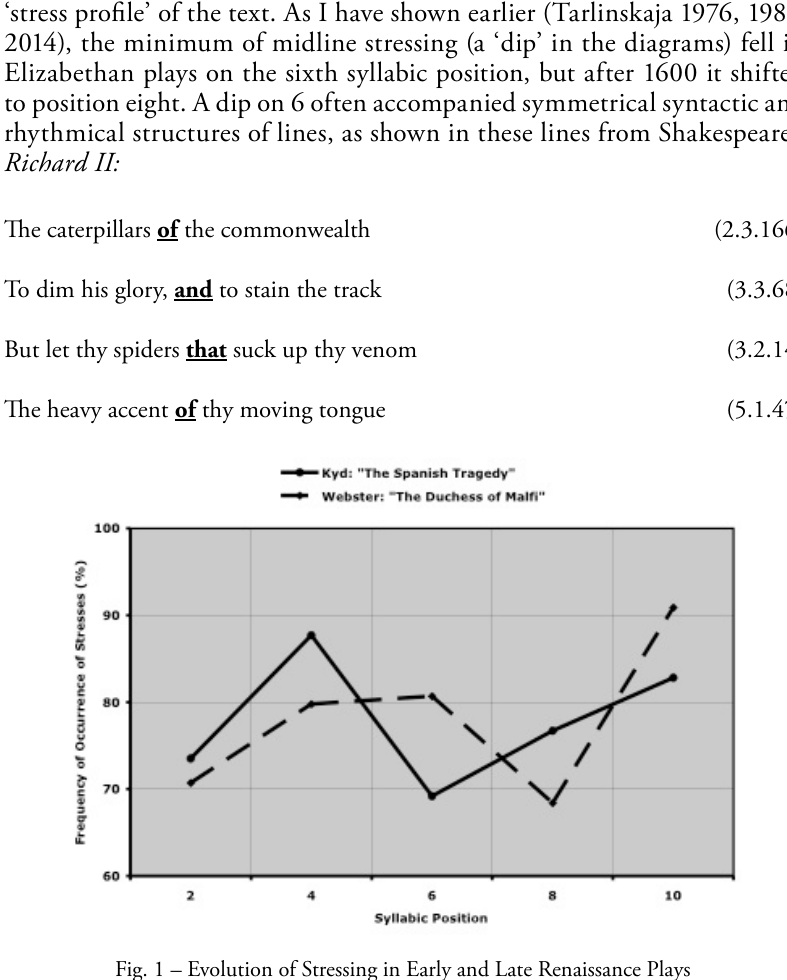
Fig. 1 – Evolution of Stressing in Early and Late Renaissance